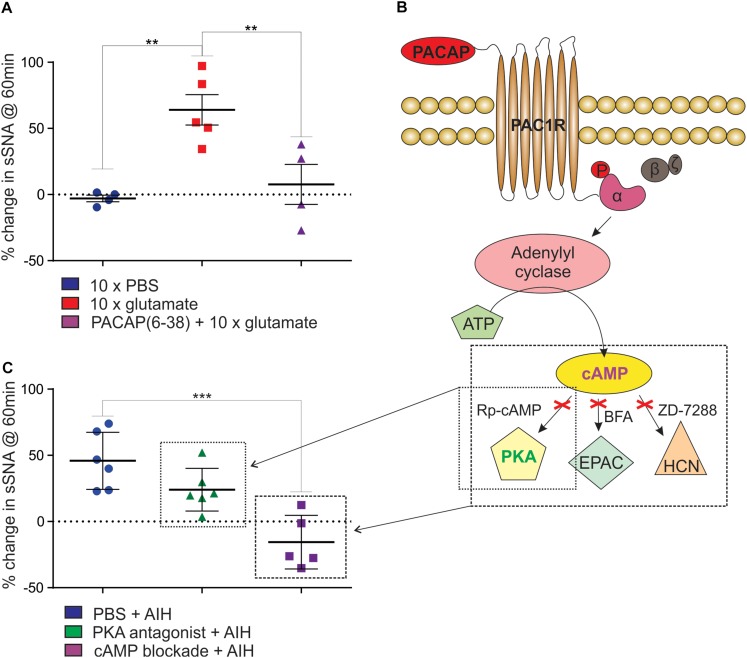
Intermittent activation of rat RVLM mimics AIH, mediated by PACAP in a cAMP-dependent manner. (A) Intermittent injections of 5 nmol glutamate in the RVLM cause a persistent increase in sympathetic nerve activity, which does not occur after intermittent injection of the vehicle control, PBS. The sympathetic response following intermittent glutamate injections is abolished by prior intrathecal infusion of the PACAP antagonist, 10 nmol PACAP(6–38). (B) An illustration of the intracellular signaling pathway used by PACAP. When PACAP binds to the PAC1 G-protein coupled receptor, the α-subunit of the G-protein is phosphorylated (“P”), adenylyl cyclase is then activated causing the conversion of ATP into cAMP. cAMP acts at 3 downstream effector proteins, Protein Kinase A (PKA), Exchange Protein Activated by cAMP (EPAC) and hyperpolarization-activated cyclic nucleotide-gated (HCN) channels. The activity of cAMP can be blocked by using a cocktail of 1μmol Rp-Diastereomer of Adenosine 3′,5-Cyclic Monophosphorothioate (Rp-cAMP), 10 nmol Brefeldin A (BFA) and 30 nmol 4-(N-Ethyl-N-phenylamino)-1,2 dimethyl-6-(methylamino)pyrimidium chloride (ZD-7288) to block the three downstream effector proteins. (C) When PKA alone is blocked using 1 μmol Rp-cAMP (small box in B) there is no significant reduction in the response to AIH. When cAMP is blocked with 1 μmol Rp-cAMP, 10 nmol BFA and 30 nmol ZD-7288 (large box in B), the sympathetic response to AIH is abolished. ∗∗P < 0.01, ∗∗∗P < 0.001.